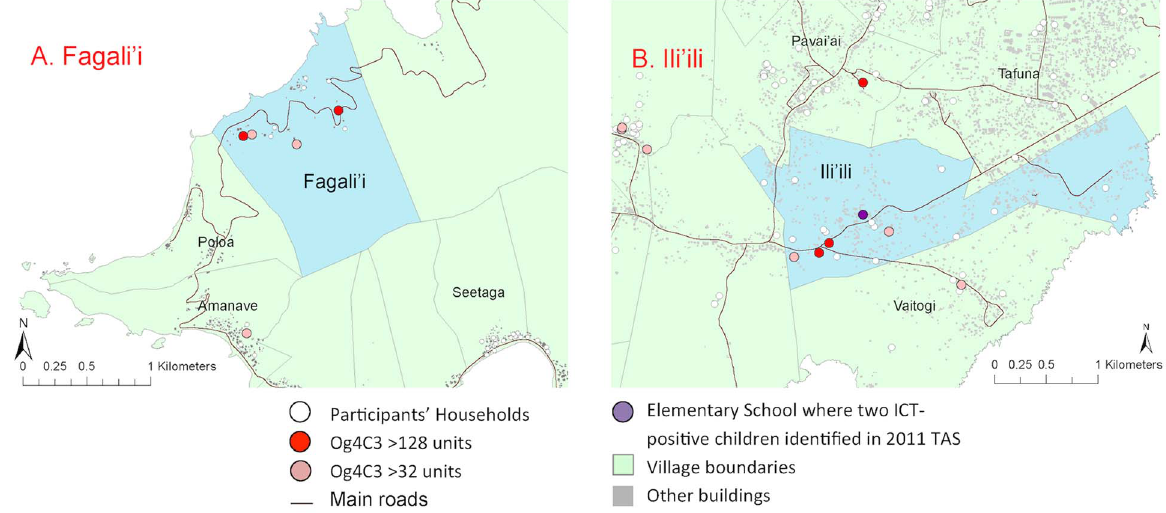
Figure 6. High resolution village maps of A. Fagali’I and B. Ili’ili, showing household locations of individuals with Og4C3 antigen of . 128 units and . 32 units, and school where two ICT-positive children identified in 2011